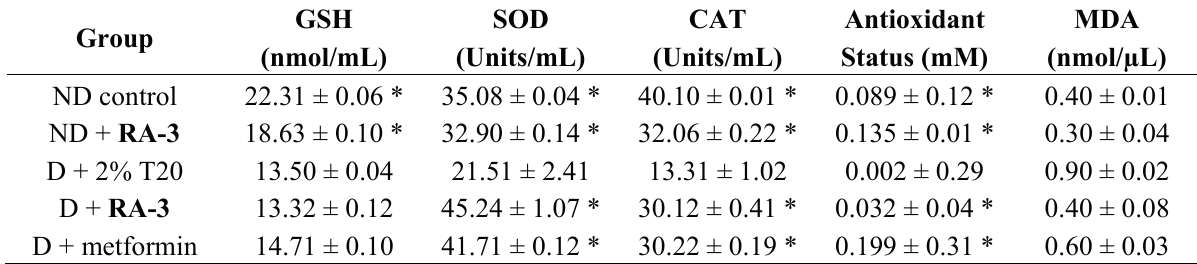
Table 3. Effect of RA-3 on MDA level, GSH content, SOD and CAT